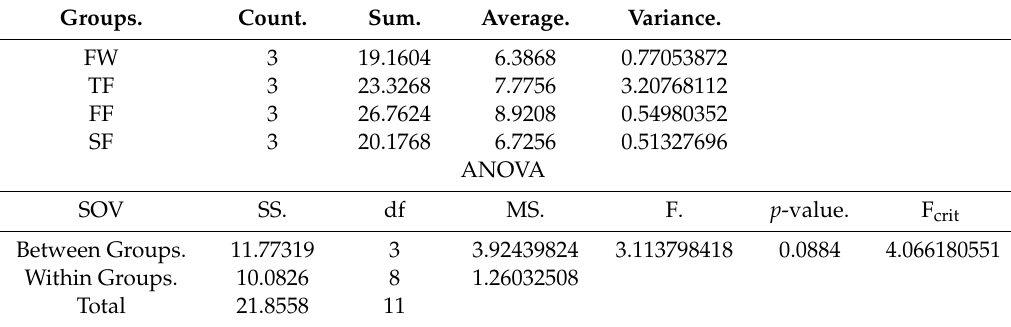
Table 8. Results of ANOVA test for the STS of RAGC mixes made with di ff erent types of e ffl uent at 28-days. Groups. Count. Sum. Average. Variance. FW 3 7.013 2.3375 0.001383937 TF 3 8.225 FF 3 6.757 SF 3 6.567 2.189 0.067540688 ANOVA SOV SS. df MS. F p -value F crit Between Groups. 0.556411 3 0.185470313 Within Groups. 0.751274